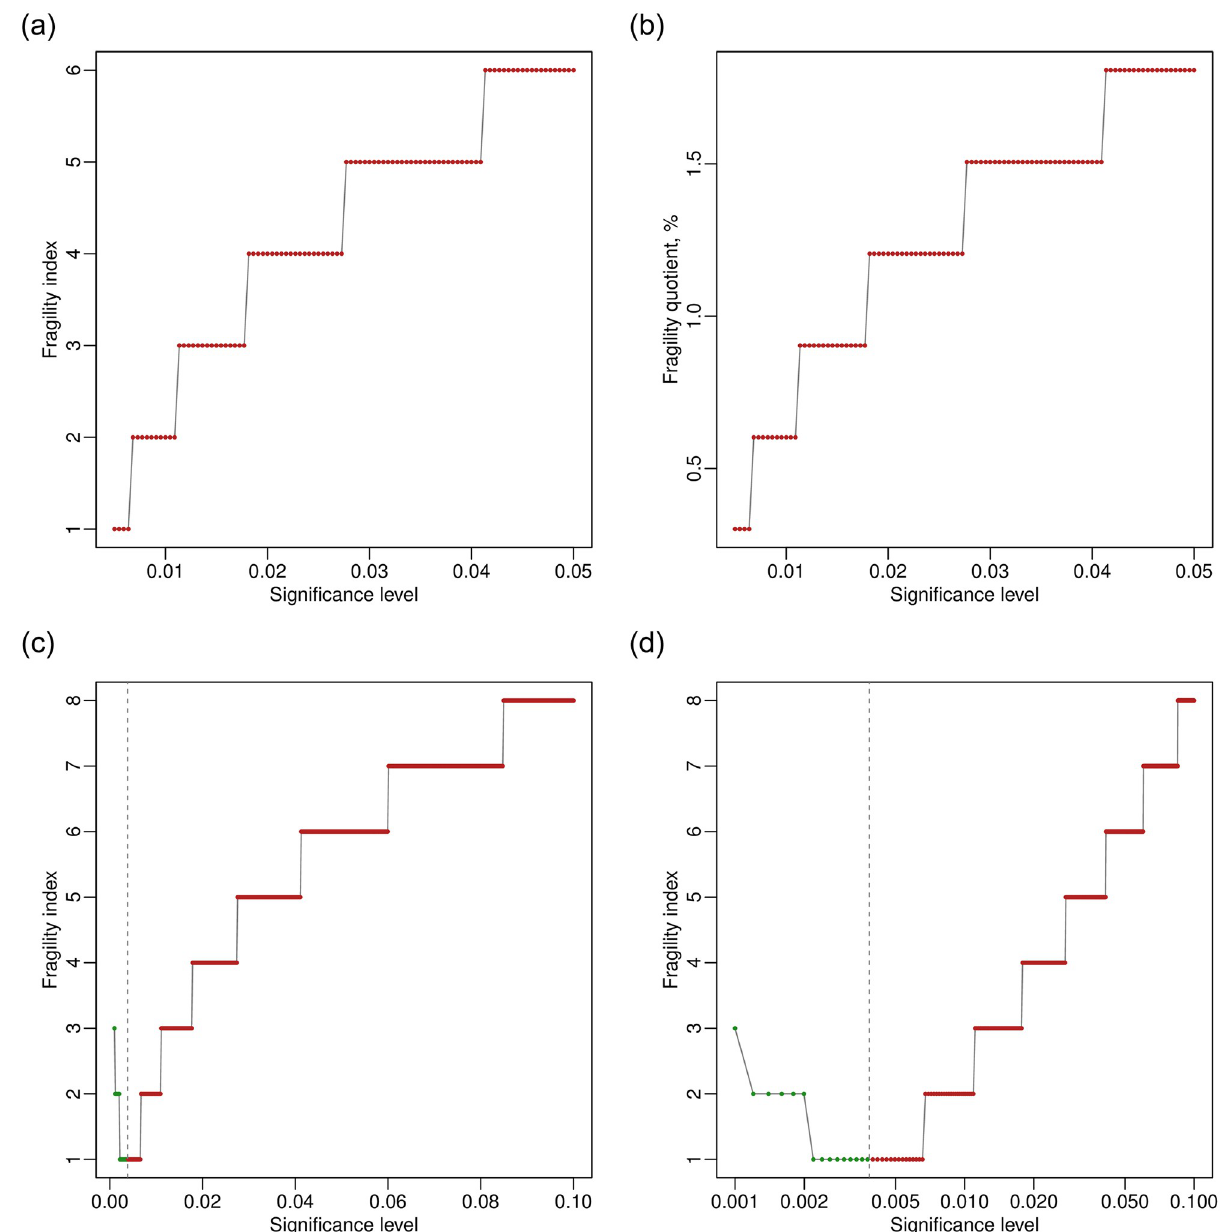
Fig 8. Visualizations of trial 13 in the dat.ad dataset at multiple significance levels. (a) Fragility index at α from 0.005 to 0.05. (b) Fragility quotient at α from 0.005 to 0.05. (c) Fragility index at α from 0.001 to 0.1. (d) Fragility index at α from 0.001 to 0.1 with the x axis on a logarithmic scale.